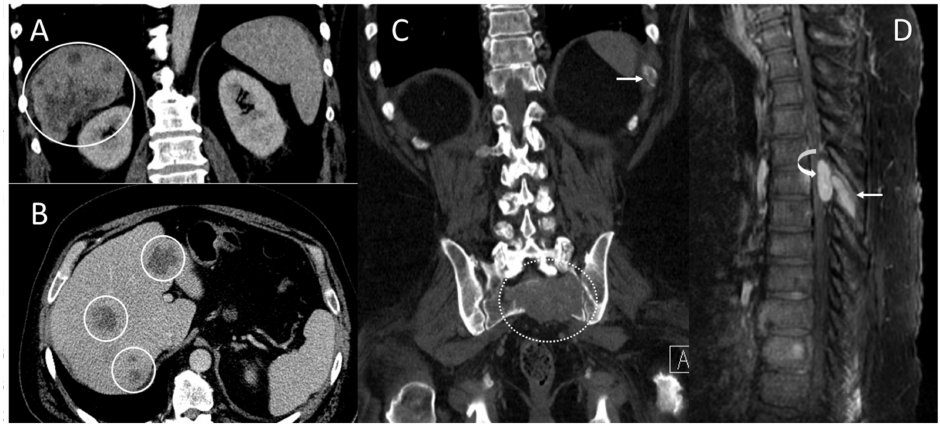
Figure 1. Computed tomography (CT) scans and magnetic resonance imaging (MRI) scans at initial diagnosis showed metastatic lesions in the liver, left 11th rib, 6th thoracic spine (T6), and sacrum. ( A ) Coronal and ( B ) axial contrast-enhanced CT scans demonstrate multifocal heterogeneous irregular hepatic tumors of varying sizes throughout the liver (solid circles) primarily in the right hepatic lobe. ( C ) Coronal CT scans in bone window demonstrate a lytic bone metastasis involving the left eleventh rib (arrow) and a large, destructive upper sacral metastasis (dashed circle). ( D ) Sagittal contrast-enhanced MRI scans demonstrate an enhancing mid-thoracic spine epidural metastasis (curved arrow) with an adjacent bone metastasis involving the T6 spinous process (arrow).